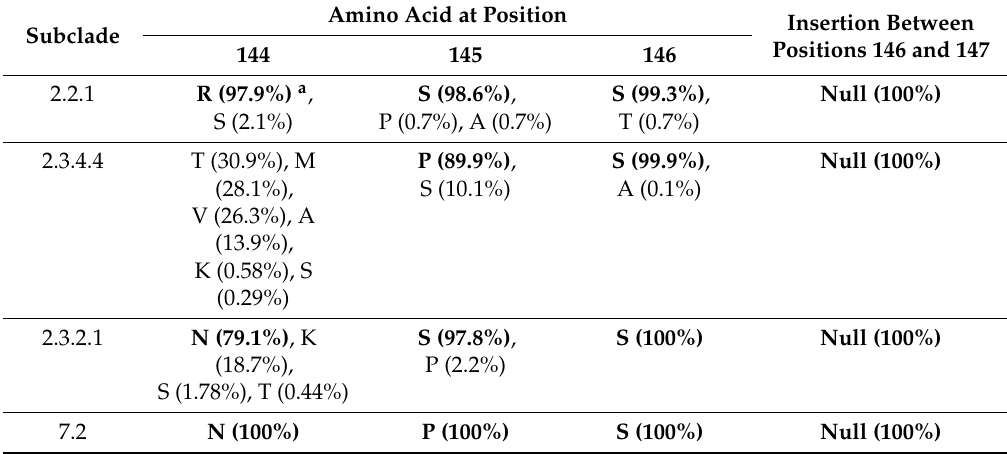
Table 8. Amino acid variation at positions 144 to 147 of H5-HA.